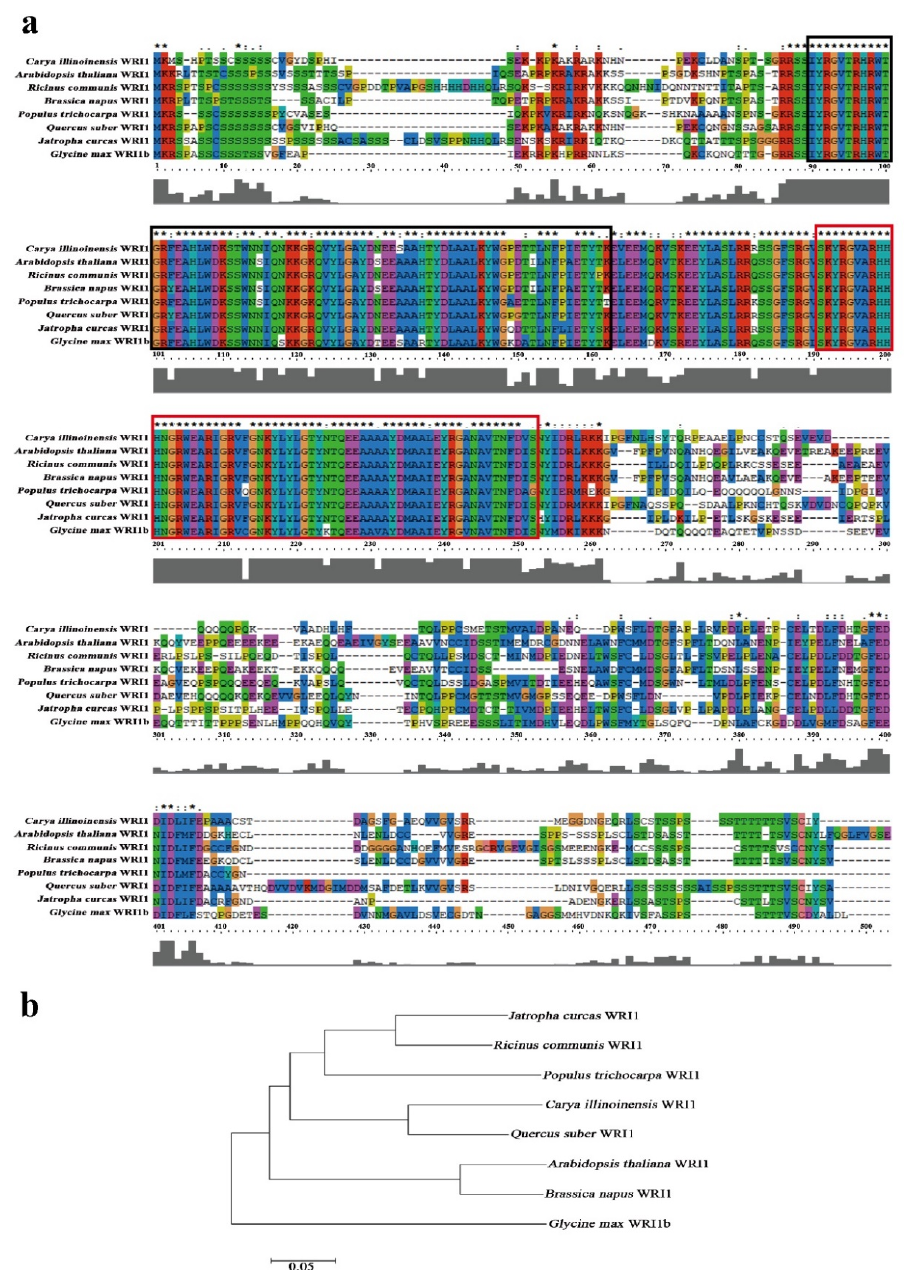
Figure 3. Sequence alignment of CiWRI1 in different plant species. ( a ) Amino acid sequence alignment of CiWRI1 and WRI1-like proteins from different species. ( b ) Phylogenetic analysis of CiWRI1 and WRI1-like proteins. Black box indicates the first AP2 DNA-binding domain and the second AP2 DNA-binding domain is in red.